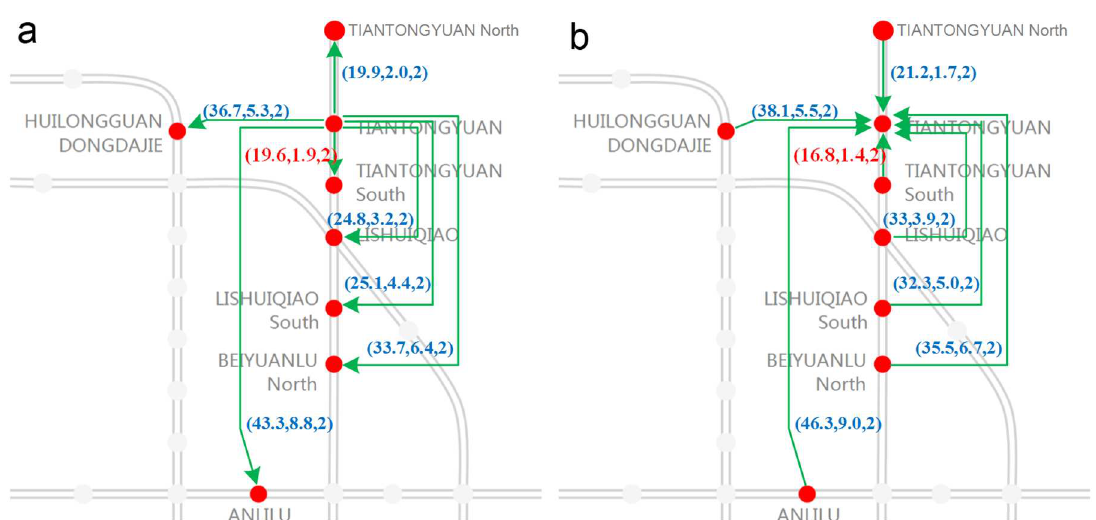
Fig 11. The total time consumption, distance and fee between the TIANTONGYUAN station and nearby stations. The parameters ( t , d , f ) on each arc that are marked by a red arrow are the total journey time (minutes), distance(kilometers) and fee (RMB) by bus, includingthe walkingduring the trip. (a) denotesthe travel cost from the closed station to some nearby stations. (b) indicatesthe travel cost from the nearby stations to the closed station. It should be noted that the travel costs on the bidirectionalarcs betweenthe same two stations may be different.